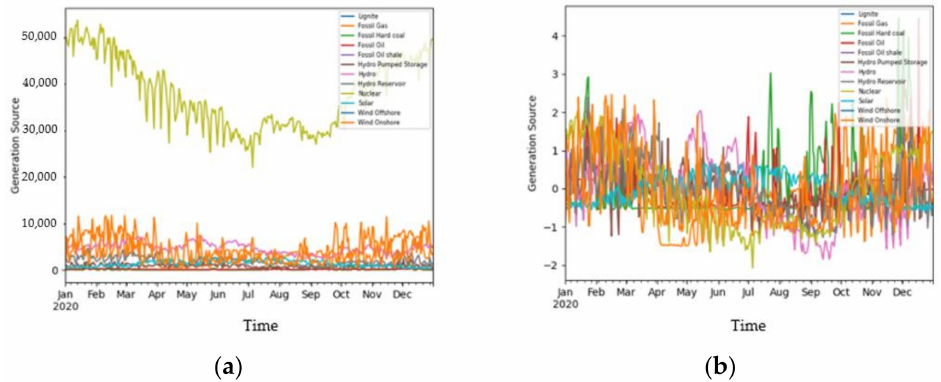
Figure 4. This figure represents the French electricity generation. ( a ) Shows an approach using data standardization which has been defined in Formula (3); ( b ) Shows the electricity generation sources in MWh. Figures 3–5 got generated using the same code in